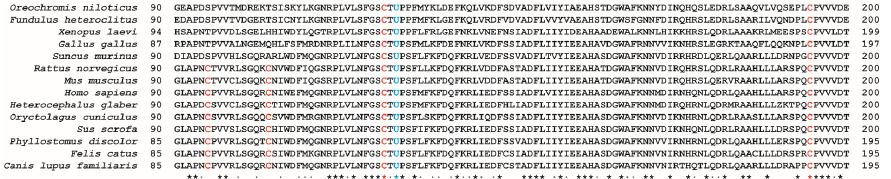
Figure A1. Multiple alignment of vertebrate DIO1 peptide sequences indicating conserved cysteines (red) and selenocysteine (blue). The alignment was performed with CLUSTAL W. * invariant amino acid. SwissProt identifiers correspond to the following species: Oreochromis niloticus (Nile tilapia), Fundulus heteroclitus (Atlantic killifish), Xenopus laevis (African clawed frog), Gallus gallus (domestic chicken), Suncus murinus (Asian house shrew), Rattus norvegicus (brown rat), Mus musculus (house mouse), Homo sapiens (human being), Heterocephalus glaber (naked mole-rat) (protein inferred from homology), Oryctolagus cuniculus (European rabbit), Sus scrofa (domestic pig), Phyllostomus discolor (pale spear-nosed bat) (protein inferred from homology), Felis catus (domestic cat), and Canis lupus familiaris (domestic dog).